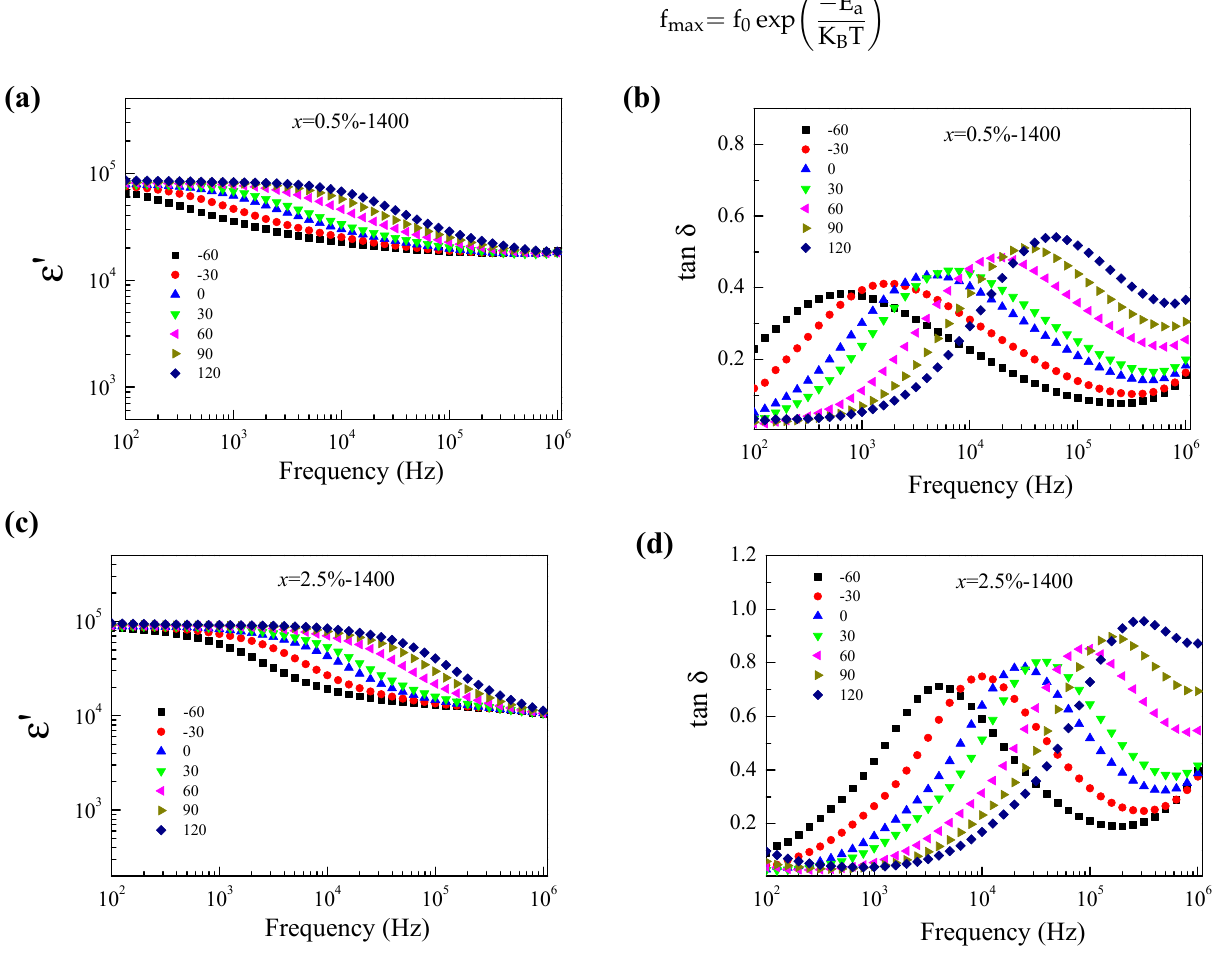
Figure 7. Temperature dependence of the ( a , c ) dielectric relaxation and ( b , d ) tan δ at different frequencies for ZNTO ceramics with x = 0.5 and 2.5% respectively.